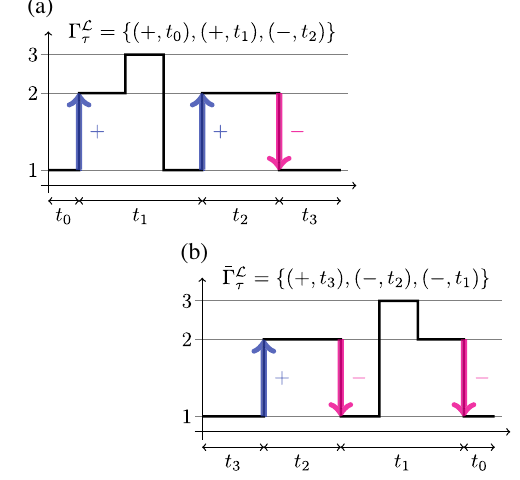
FIG. 5. (a) Hidden trajectory over states f 1 ; 2 ; 3 g and the observation Γ L τ for τ ¼ t 0 þ t 1 þ t 2 þ t 3 and L ¼ fþ ∶ 1 → 2 ; −∶ 2 → 1 g . (b) Time-reversed hidden trajectory ¯ Γ L and resulting τ